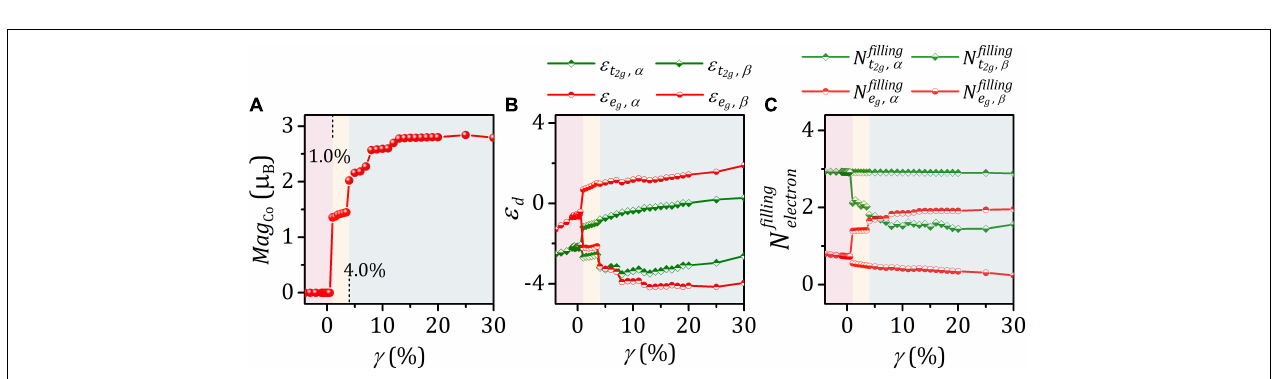
FIGURE 2 | (A) Crystal structure of LaCoO 3 and (B) corresponding band structure. (C) Strain energy of LaCoO 3 versus strain γ and strain–stress curve.